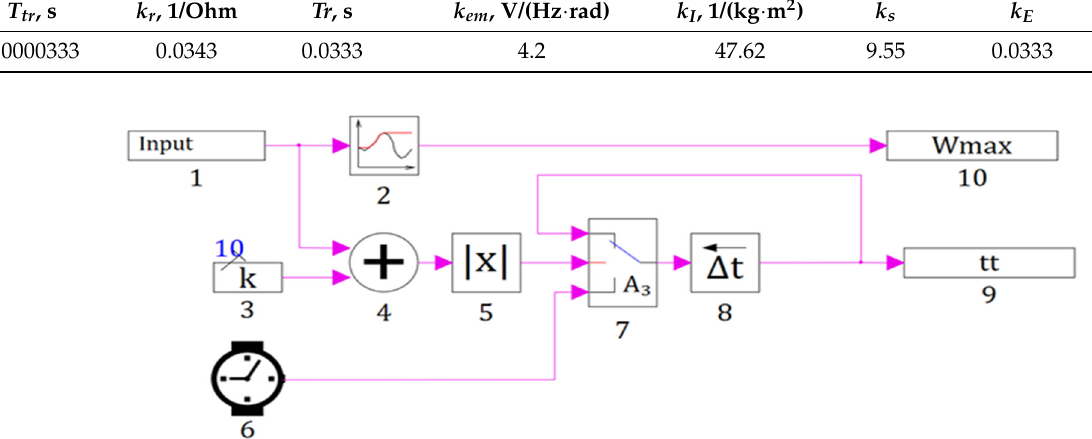
Figure 5. Schematic window with the transient time calculation block